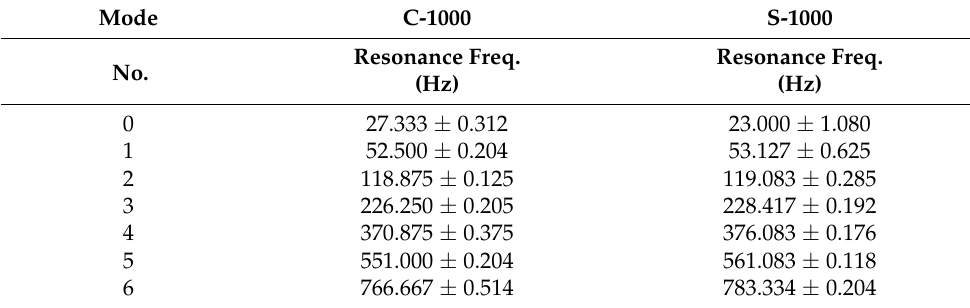
Table 8. Identified natural frequencies for the 1000